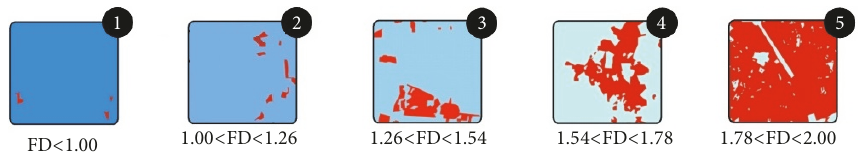
Figure 3: Variation of the fractal dimension FD as a function of the space filling level [18].